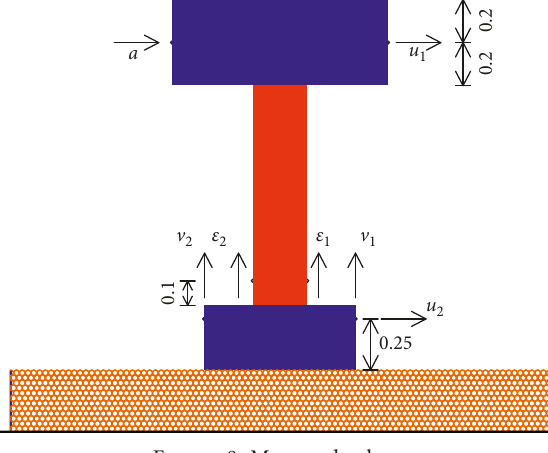
Figure 8: Measured Figure 10. It is found that the rigid base produced maximum acceleration for all considered accelerograms and that the maximum accelerations for the pebble layer were similar. Compared to the rigid base, thin layer with large pebbles produced the lowest reduction in acceler- � 3.0 m · s − 2 , the highest acceleration on ation. For a g,max the rigid base was produced by AA (approx. 11.6 m · s − 2 ), whereas the lowest was produced by ABL (approx.